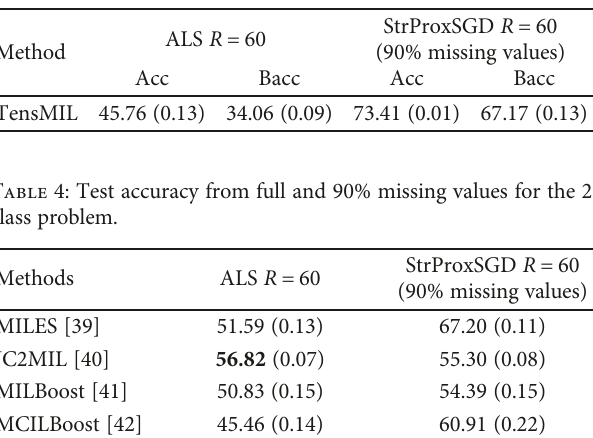
Table 3: Test accuracy and balanced accuracy from full and 90% missing values for the 3 class problem.